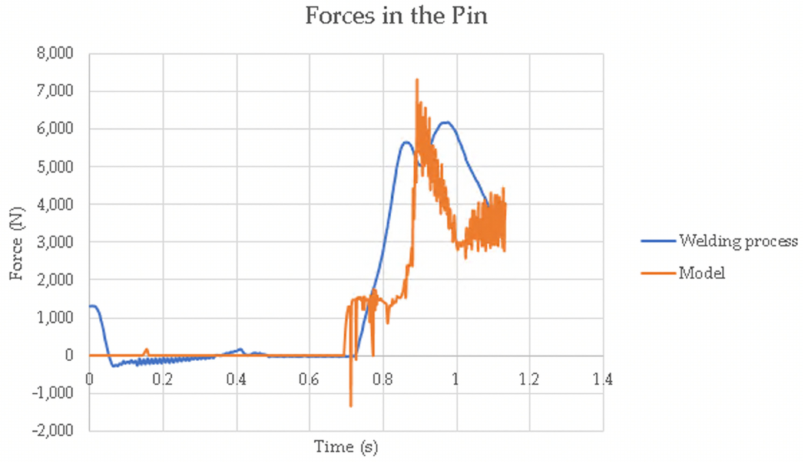
Figure 17. Comparison of forces on the pin during the RFFSW process.